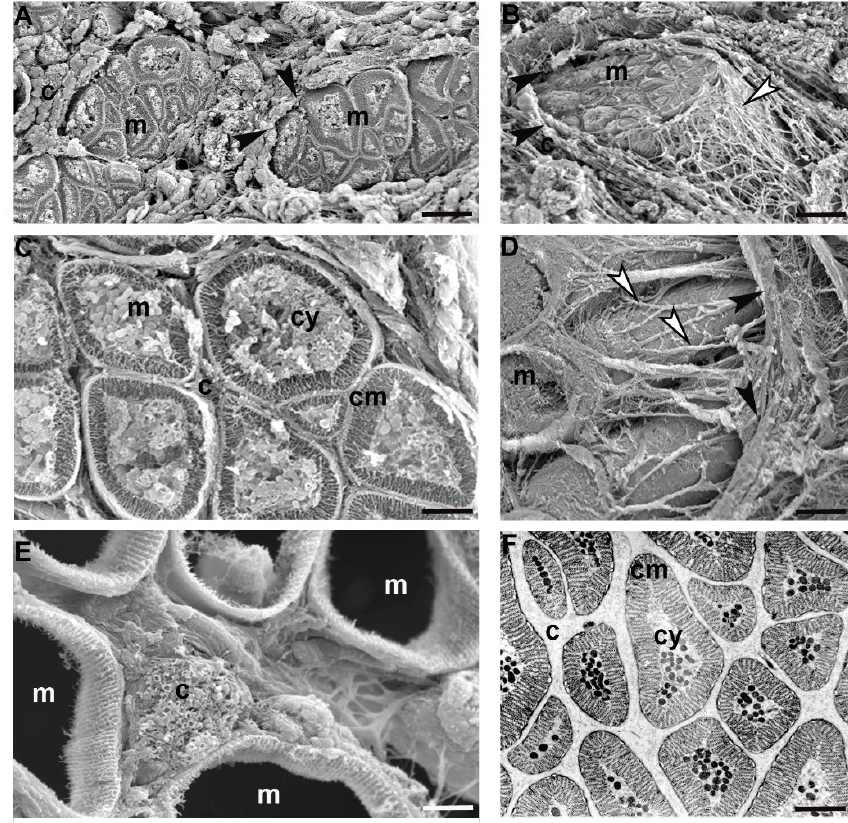
Figure 2. Adult H. verbana in cross section. Scanning (SEM) and transmission (TEM) electron microscopy. SEM ( A – E ) and TEM ( F ) analysis. Circomyarian muscle fibres (m) formed groups lined by connective tissue (black arrowheads). Collagen scaffold (white arrowheads), surrounding each group of fibres, ensure a mechanical link among muscle fibres and connective capsule. ( B , D ). Fibres, characterized by a ring of contractile material (cm) encircling a cytoplasm core (cy), are separated from their neighbours by non-structured extracellular matrix (c) better visible with SEM radical fixation ( F ). Scale bars: ( B ) 12.6 μ m; ( A ) 12 μ m; ( C , D ) 4.5 μ m; ( F ) 3.4 μ m; ( E ) 1.3 μ m.